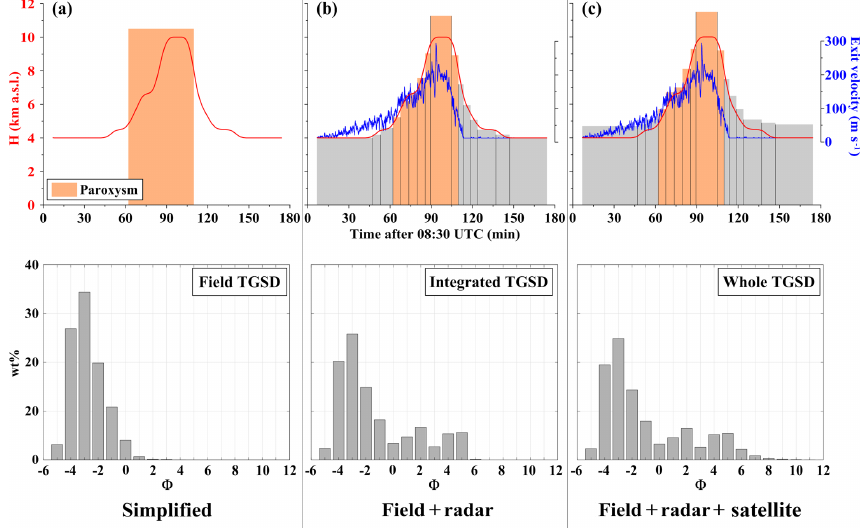
Figure 7. Simulation schemes. (a) Simplified procedure. (b) Discretization of the eruption into a set of phases to account for the temporal variation of the intensity (i.e. column height, hence MER, and exit velocity). The improved scheme is accompanied by the Integrated TGSD and ARPAE database. (c) Same procedure as (b) with the Whole TGSD and ERA-Interim.